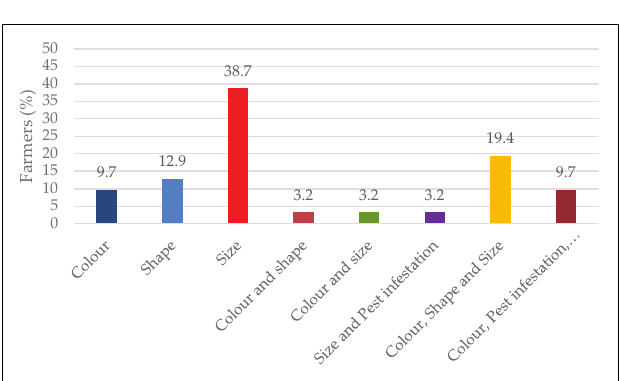
FIGURE 9 | Seed sorting criteria of lablab for